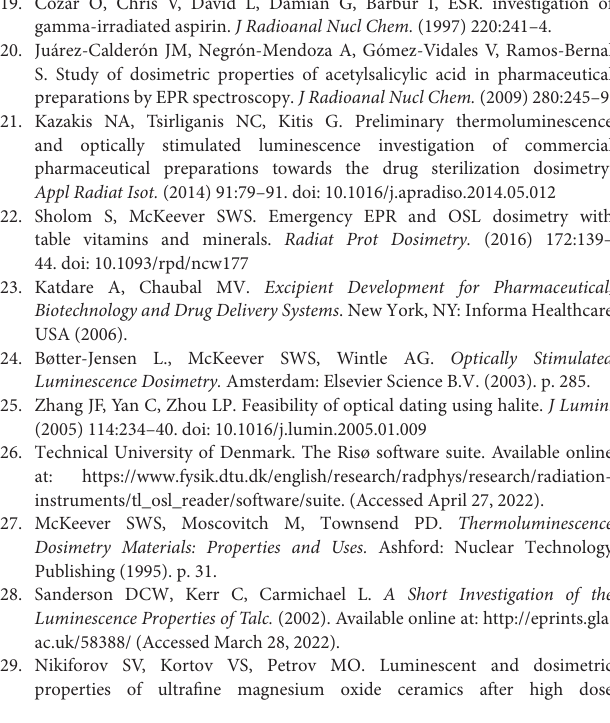
table vitamins and minerals. Radiat Prot Dosimetry. (2016) 172:139– 44. doi: